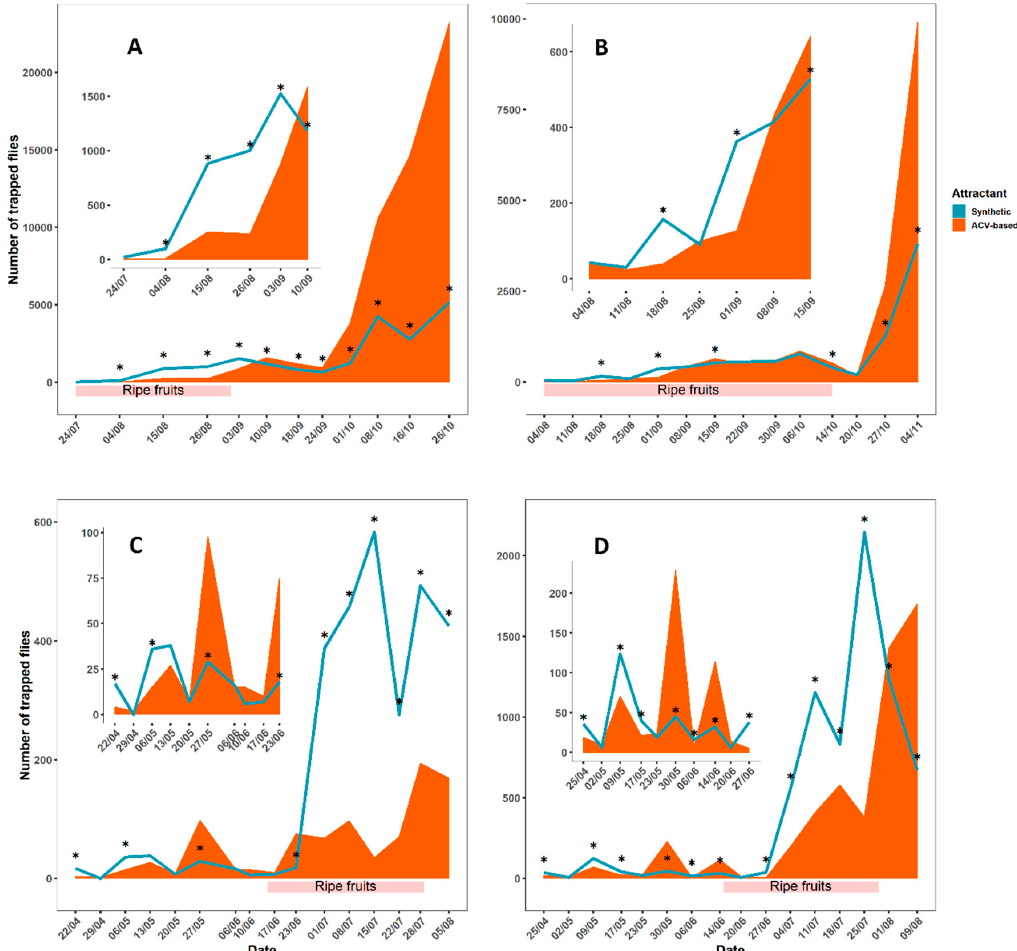
Figure 2. Field observations with synthetic lures and ACV baited traps during spring and summer in ( A ) Blueberry in 2015, ( B ) Blackberry in 2015, ( C ) Cherry (commercial) in 2016, and ( D ) Cherry (abandoned) in 2016. Each date on the horizontal axis is a sampling date for which the line graphs depict the number of D. suzukii adults captured in four traps over the interval between that and the previous sampling date. Asterisks indicate significant differences ( p < 0.05) between the estimated marginal means of the two attractants. For each graph, a zoomed section of the first part of the experiment is given, the presence of ripe fruits on the crop is represented by the bar under the plot.